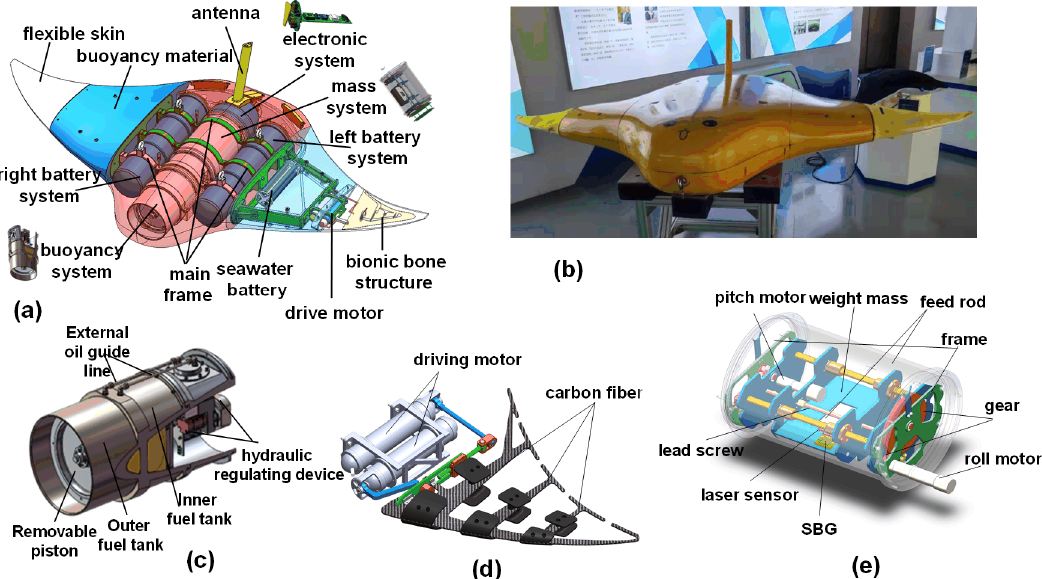
Figure 2. The structural model and prototype of the manta robot. ( a ) The three-dimensional overall structural model of the manta robot; ( b ) the manta ray robot prototype on display; ( c ) the buoyancy-adjustment system three-dimensional model; ( d ) the flexible pectoral fin model; ( e ) the mass-adjustment system’s three-dimensional model.